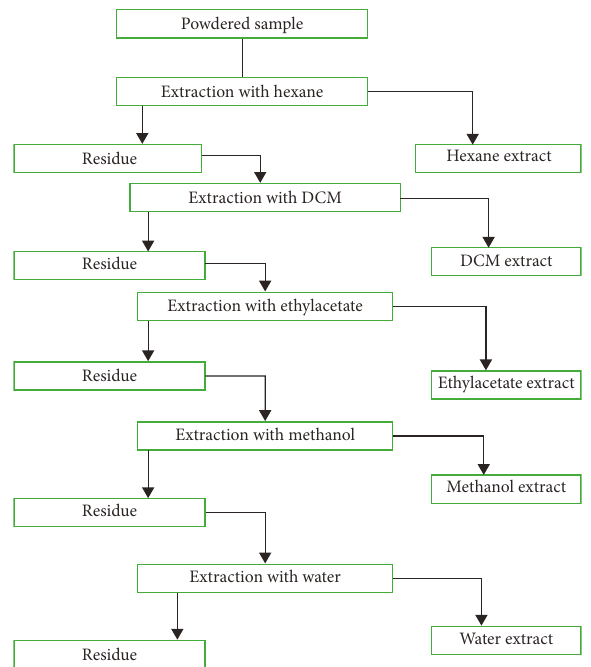
Figure 1: Flow diagram showing the extraction